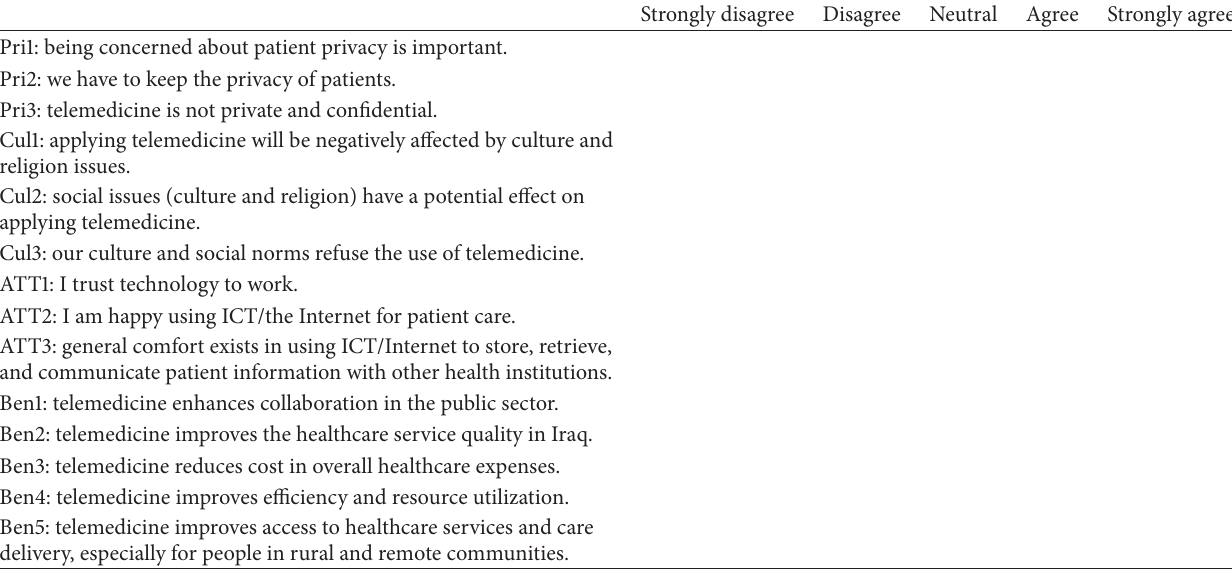
Table 5: Part 3: individual characteristic.